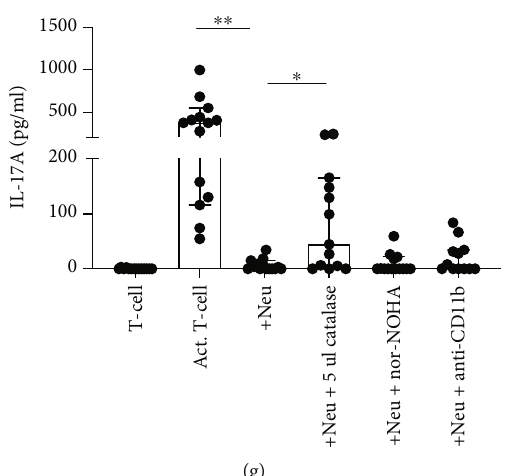
Figure 4: NDGs inhibit the cytokine production of Th cells. After 3 days of coculture together with the inhibitors catalase, nor-NOHA, and anti-CD11b, the supernatant was saved and used in CBA to measure the presence of (a) IL-2, (b) IL-4, (c) IL-6, (d) IL-10, (e) TNF, (f) IFN-g, and (f) IL-17A. Graphs show median with 95% CI ( n = 14